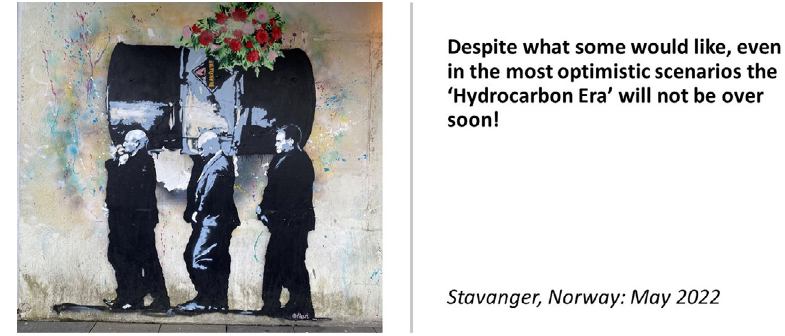
Fig. 20. – The end of hydrocarbons? Wall mural in Stavanger, Norway, May